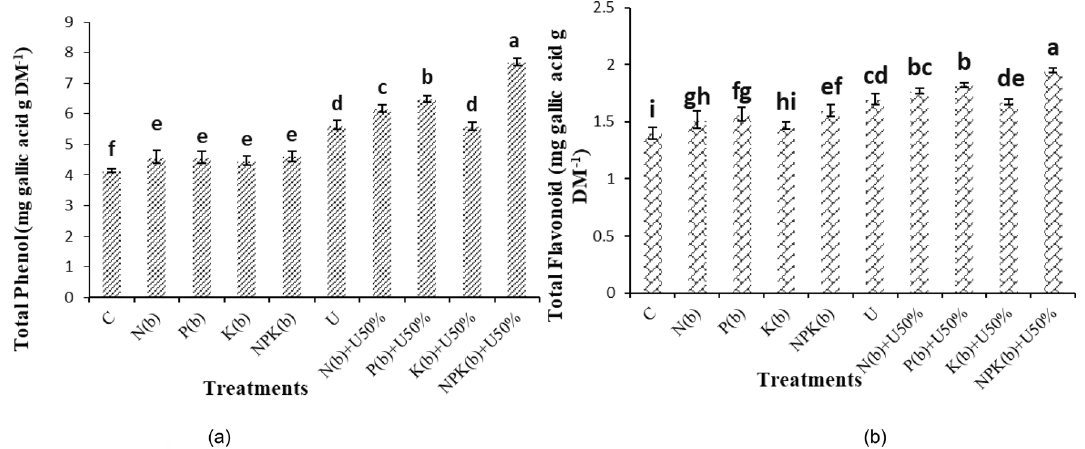
Figure 6. Means comparison for Total phenols and Total flavonoid of Nigella sativa L. as influenced by biofertilizers and urea. Dissimilar letters show significant differences at the p ≤ 0.01 level. Control (C),